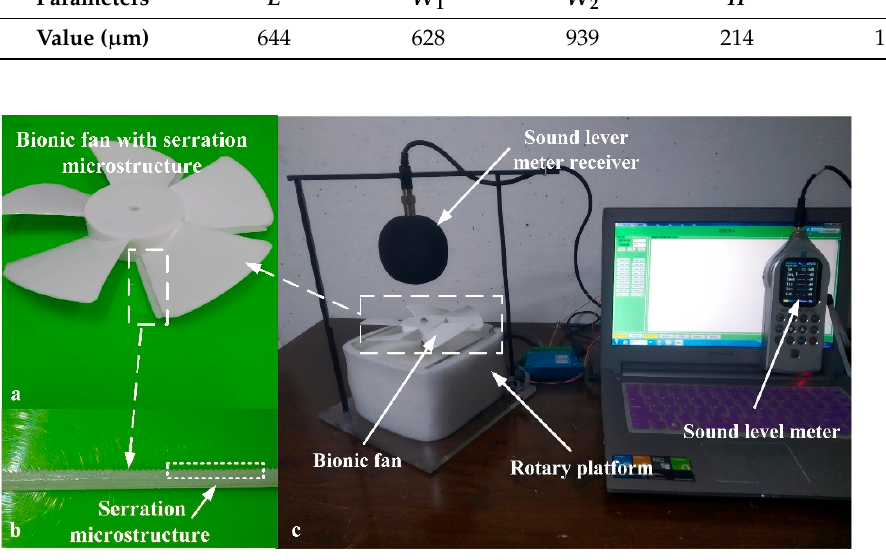
Figure 10. Noise measurement device of the rotating platform: ( a ) bionic fan, ( b ) serration microstructure chip and ( c ) rotating platform.